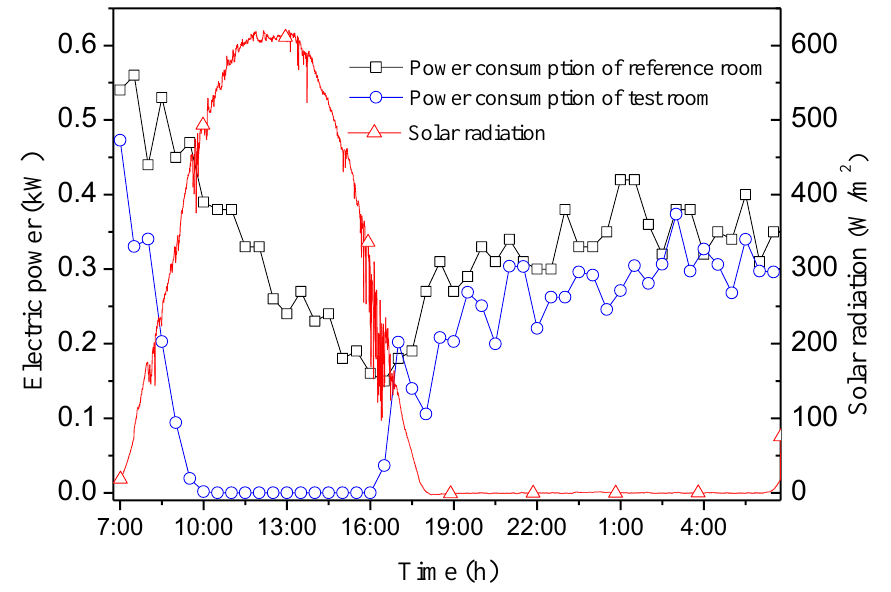
Figure 13. Electric power of test room and reference room.